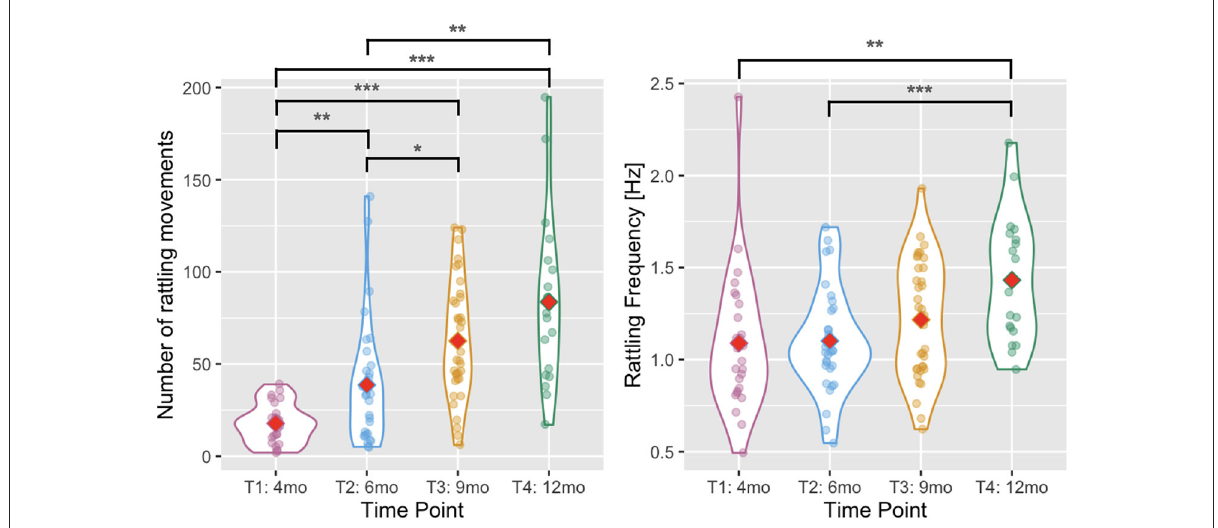
FIGURE4 Violin plots showing the number of rattling movements (left) and the rattling frequency (right) across time points. Red diamonds indicate mean values. A single asterisk indicates significance at p < 0.05, two asterisks indicate p < 0.01, and three indicate p < 0.001.